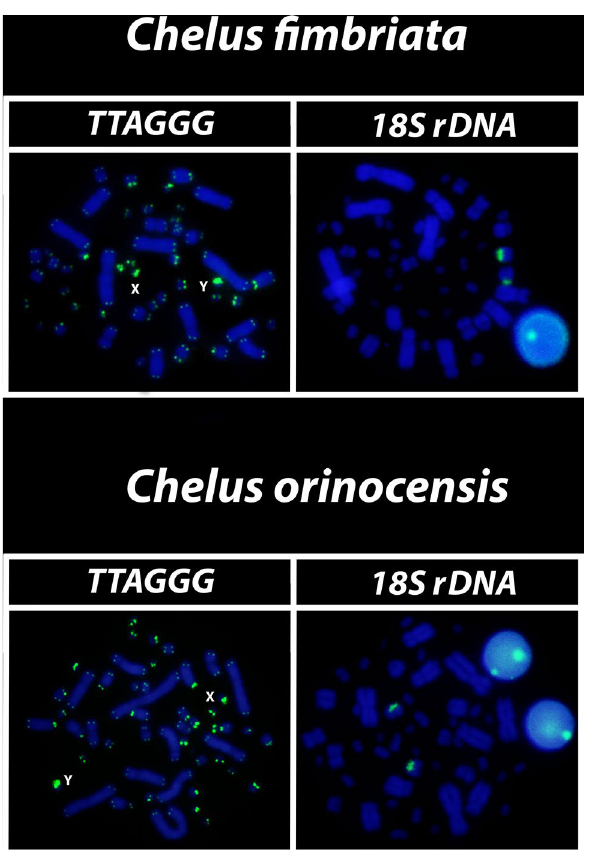
Figure 8. Mapping of telomeric motifs (TTA GGG ) n and 18S rDNA on the metaphase spreads of Chelus fimbriata and Chelus orinocensis . Please note the particular XY amplification of telomeric-like repeats in both species